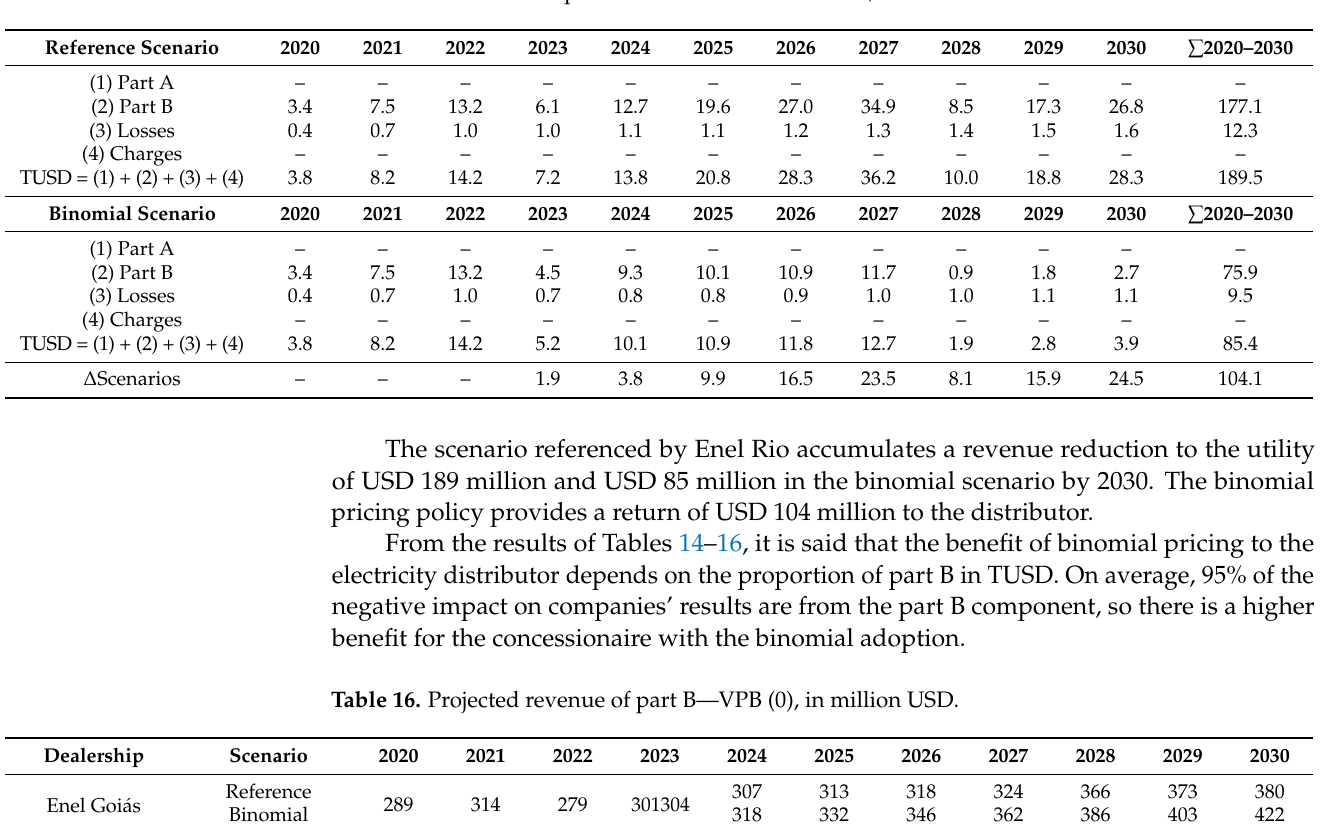
Table 15. Irrecoverable portion of MMDG for Enel Rio, in million USD.